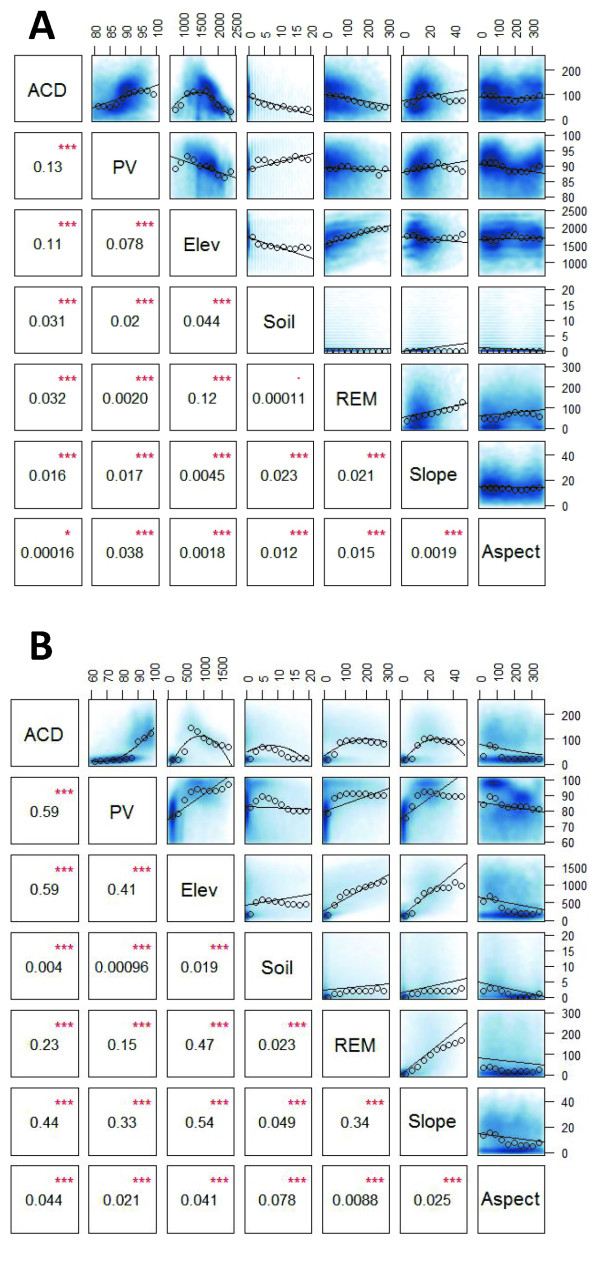
Correlation matrices relating site factors to ACD, including elevation a.s.l. (Elev in m), fraction of photosynthetic vegetation as determined by CLASlite (PV), slope (degrees), REM (elevation above nearest drainage), fraction of soil cover as determined by CLASlite, and aspect for the (A) northern region and (B) southern region. The scatter plots display the following information: blue points indicate individual pixel values, open circles represent the median value within each of ten bins evenly spaced along the horizontal axis (these are intended to assist in visualization and do not impact model fit), lines are the best fit polynomials for the data being compared. In the lower left portion of the matrix are the r2 values for the best-fit polynomials; *** indicates statistical significance of P < 0.001.